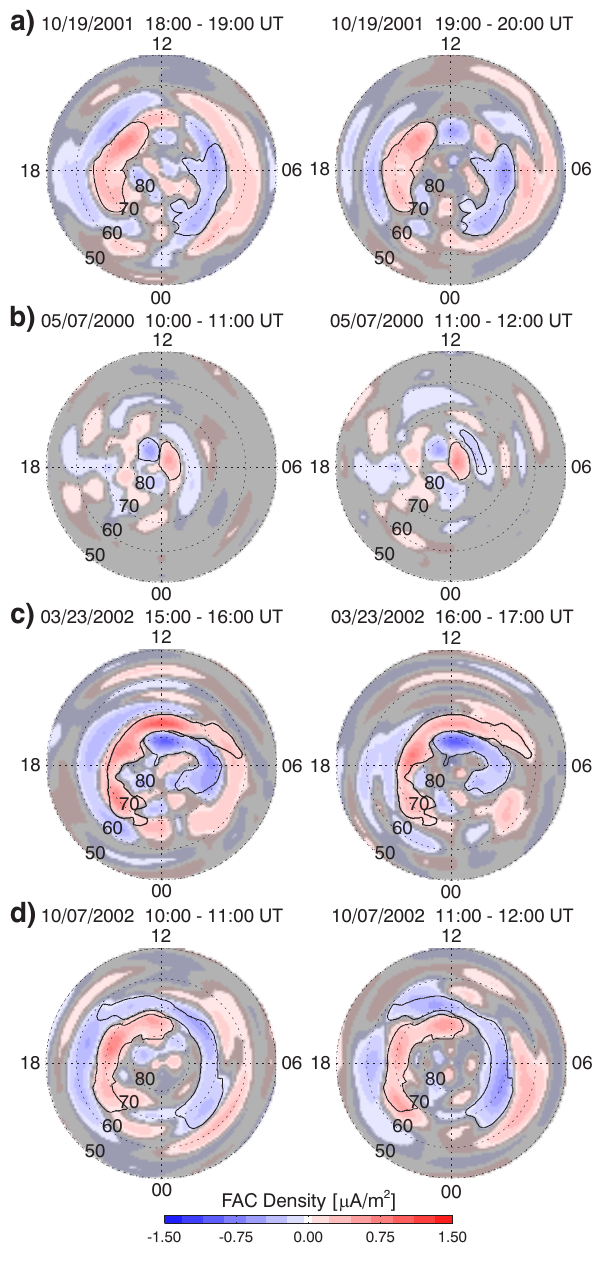
Fig. 1. Example Birkeland current distributions for (a) southward, (b) northward, (c) dawnward, and (d) duskward IMF orientation. Upward (downward) currents are in red (blue) and gray shading indicates currents below the 2 σ confidence level. Contours in the left hand panels show the overlap region identified by finding the region with maximum current density (upward or downward) in the earlier interval and evaluating the overlap of this region above the 2 σ level with the later interval. Contours on the right show the overlap found by finding the region with maximum current density first in the later interval and evaluating the overlap with the earlier interval.